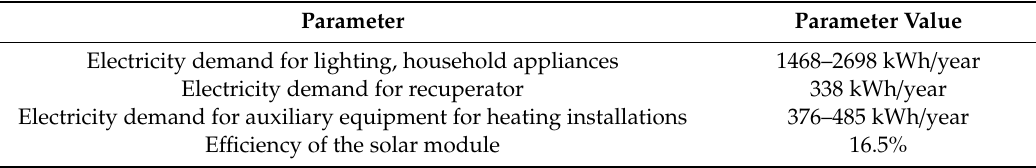
Table 5. Data accepted for calculations for electrical installations.